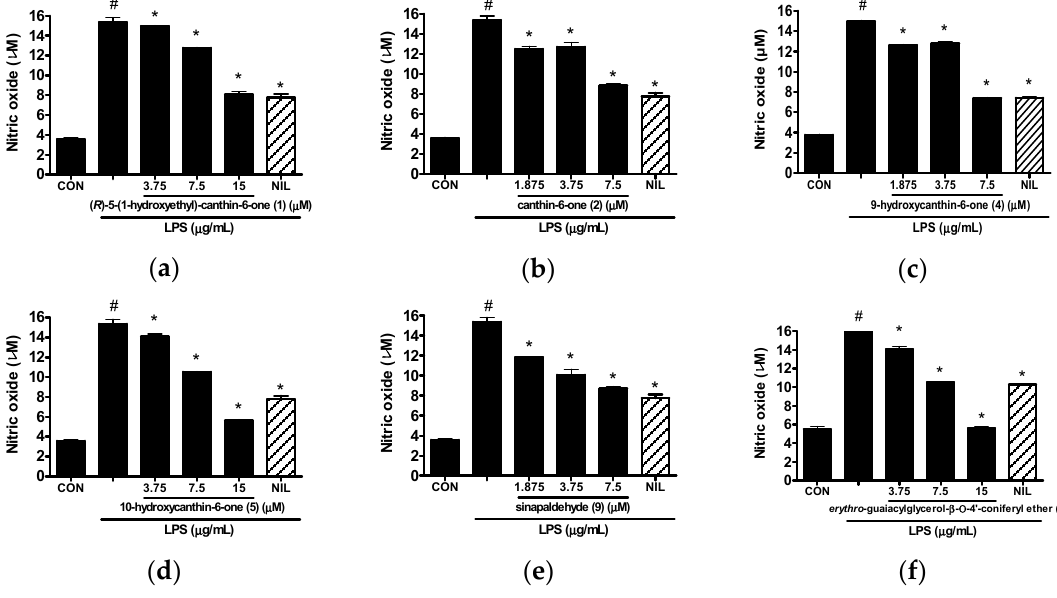
Figure 4. Effects of compounds 1 ( a ), 2 ( b ), 4 ( c ), 5 ( d ), 9 ( e ) and 11 ( f ) isolated from the stem barks of A. altissima on LPS-induced NO production in RAW 264.7 cells. Based on MTT (3-(4,5- dimethylthiazol-2-yl)-2,5-diphenyltetrazolium bromide) assay data, concentrations of isolates that would not affect cell viability were used for the following experiments. Cells were pretreated with the indicated concentrations of isolates for 1 h and then stimulated with LPS (1 µ g/mL) for 24 h. NO level in culture media was measured by Griess assay. NIL (iNOS inhibitor, 10 µ M) was used as a positive control to inhibit NO production. Values represent the means ± SD of three independent experiments. # p < 0.05 vs. the control group; * p < 0.05 vs. LPS-stimulated group. CON, control; NIL, L - N 6 -(1-iminoethyl) lysine.